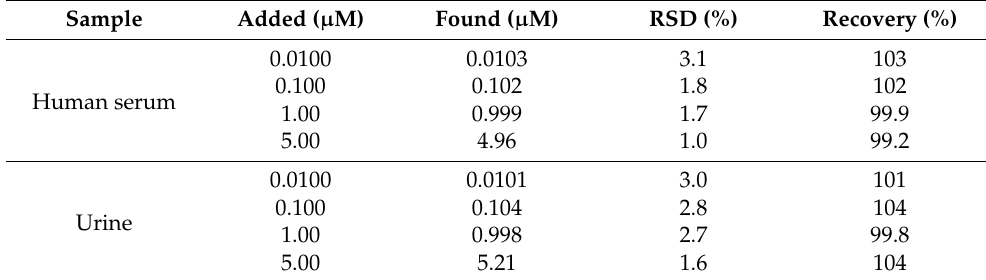
Table 2. Determination of DOX in diluted human serum and urine a